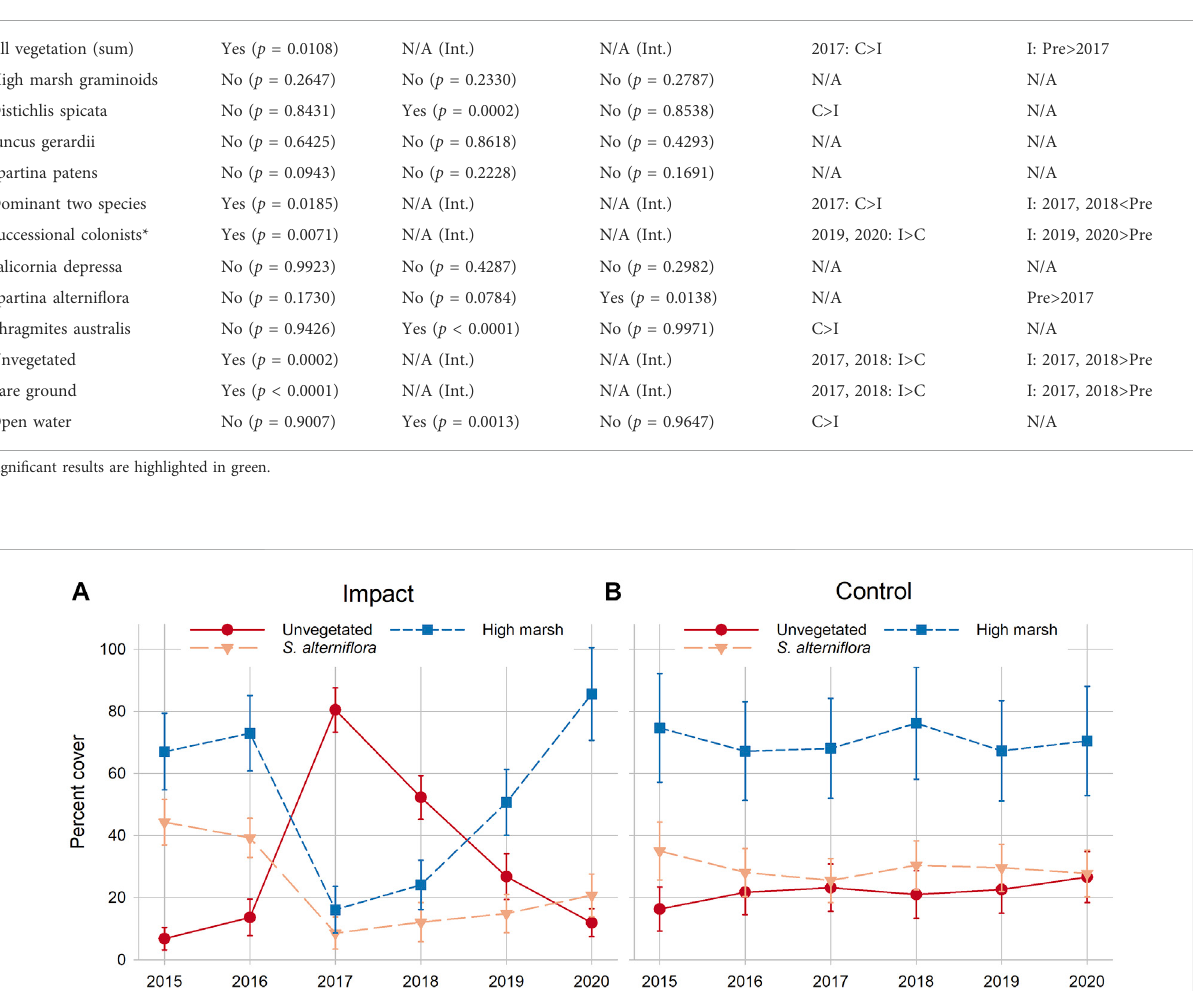
TABLE2Two-factorANOVAmaineffectsandsite×timeinteractionsexaminingvegetatedandunvegetatedcover(asindicated),usingtransectmean percent cover values. Cover type